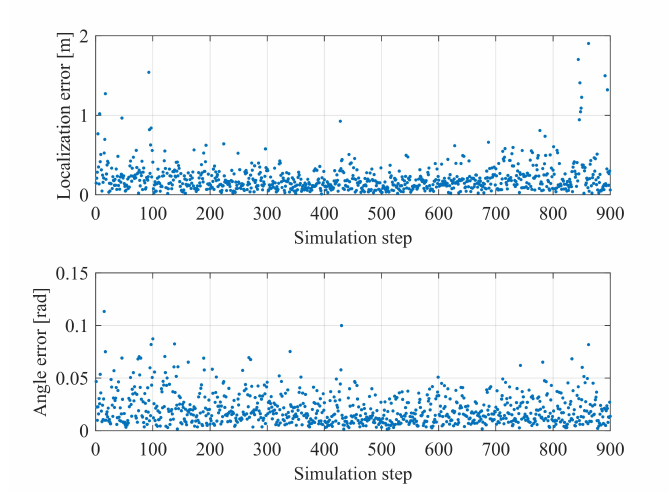
Figure 7. Horizontal localization (top row) and angle errors (bottom row) from simulation